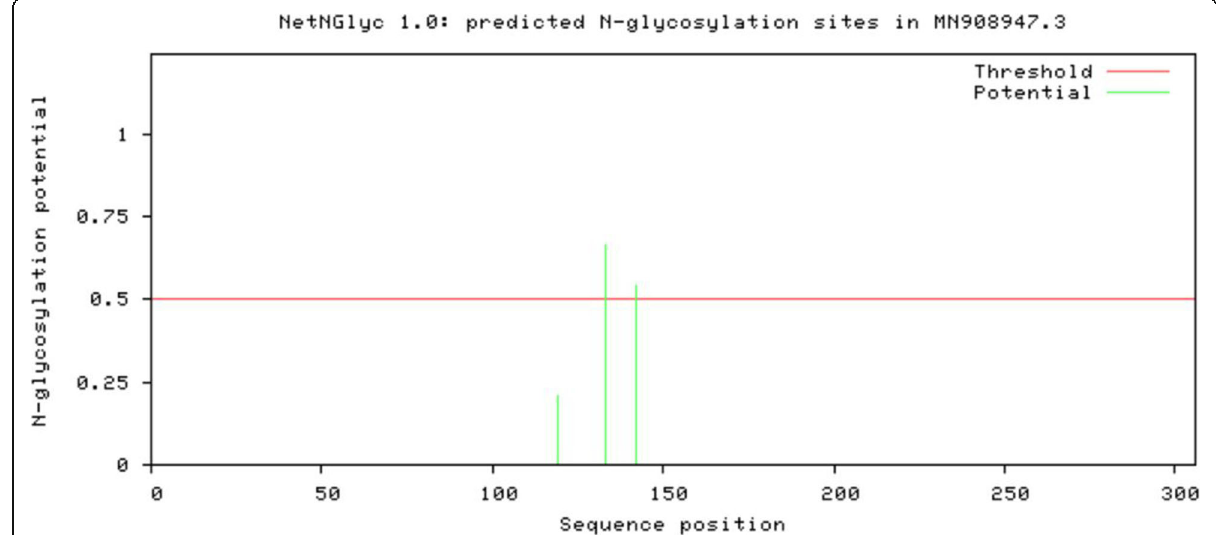
Fig. 3 Graphical output of the predicted N -glycosylation sites in the viral main proteinase amino acid sequence. The output shows a plot of the N -glycosylation potential against sequence position